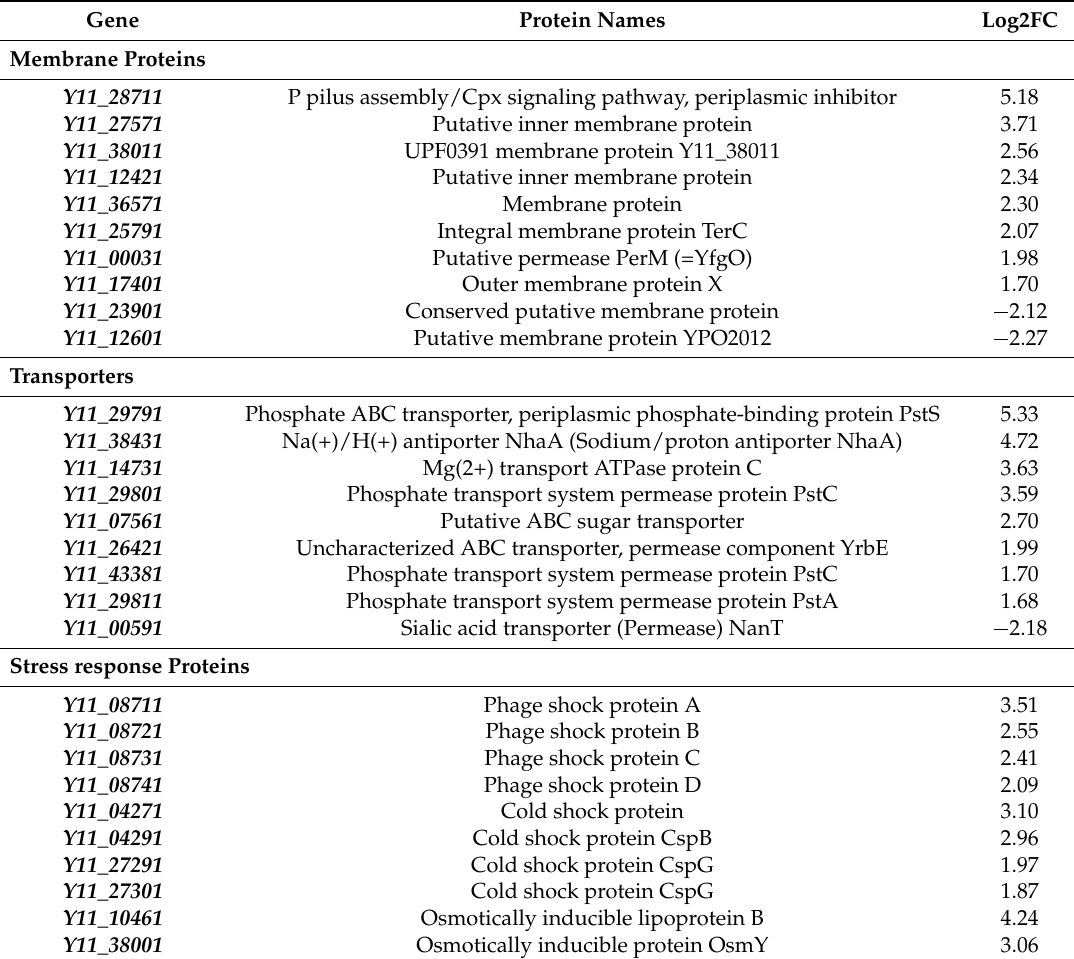
Table 2. Selected bacterial genes differentially expressed between the negative control and the late time points of phiR1-37